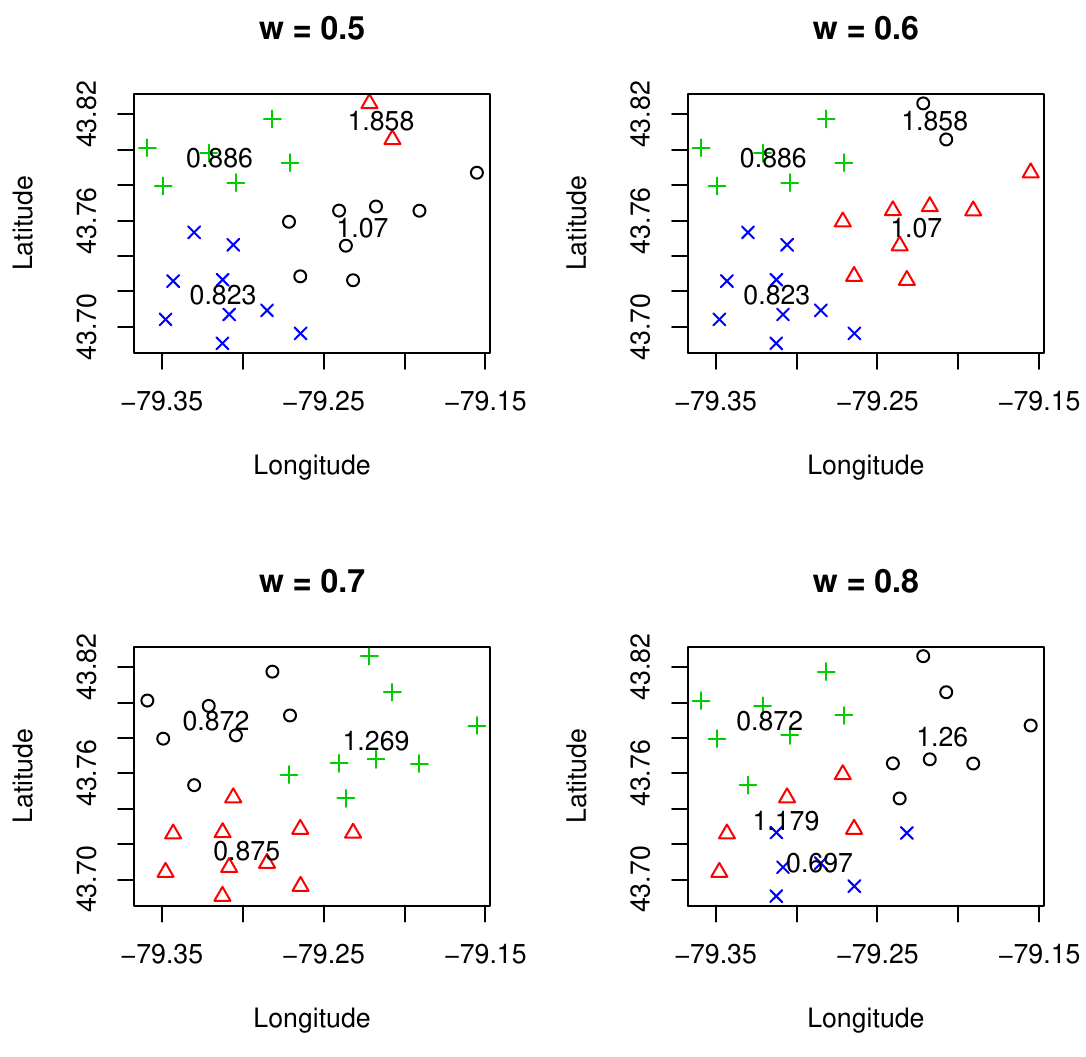
Figure 1. The weighted K -means clustering results using different values of w 1 (i.e., w 1 = 0.5, 0.6, 0.7 and 0.8, respectively) for a selected geographical area. The value indicated within each cluster represents the relativity of its loss cost to the overall average loss cost weighted by